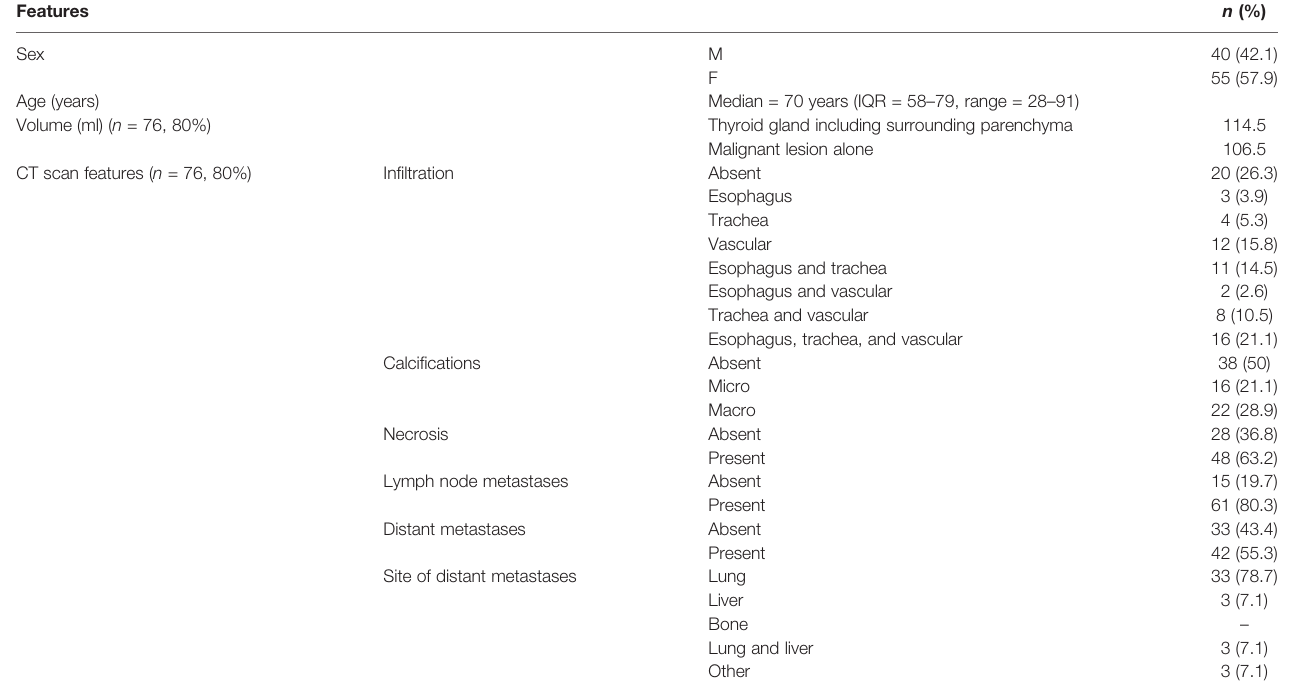
TABLE 1 | Epidemiological features of the study group ( n = 95) and CT scan features of the 76 patients (76/95, 80%) with large thyroid masses who had a CT scan in our department.